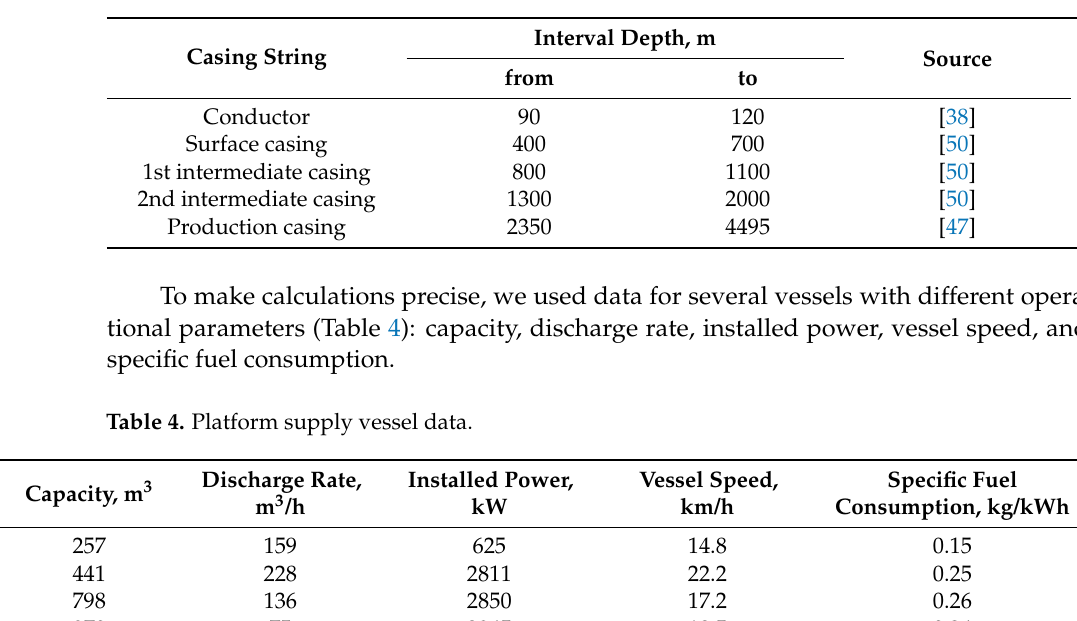
Table 3. Depth of columns and wells.